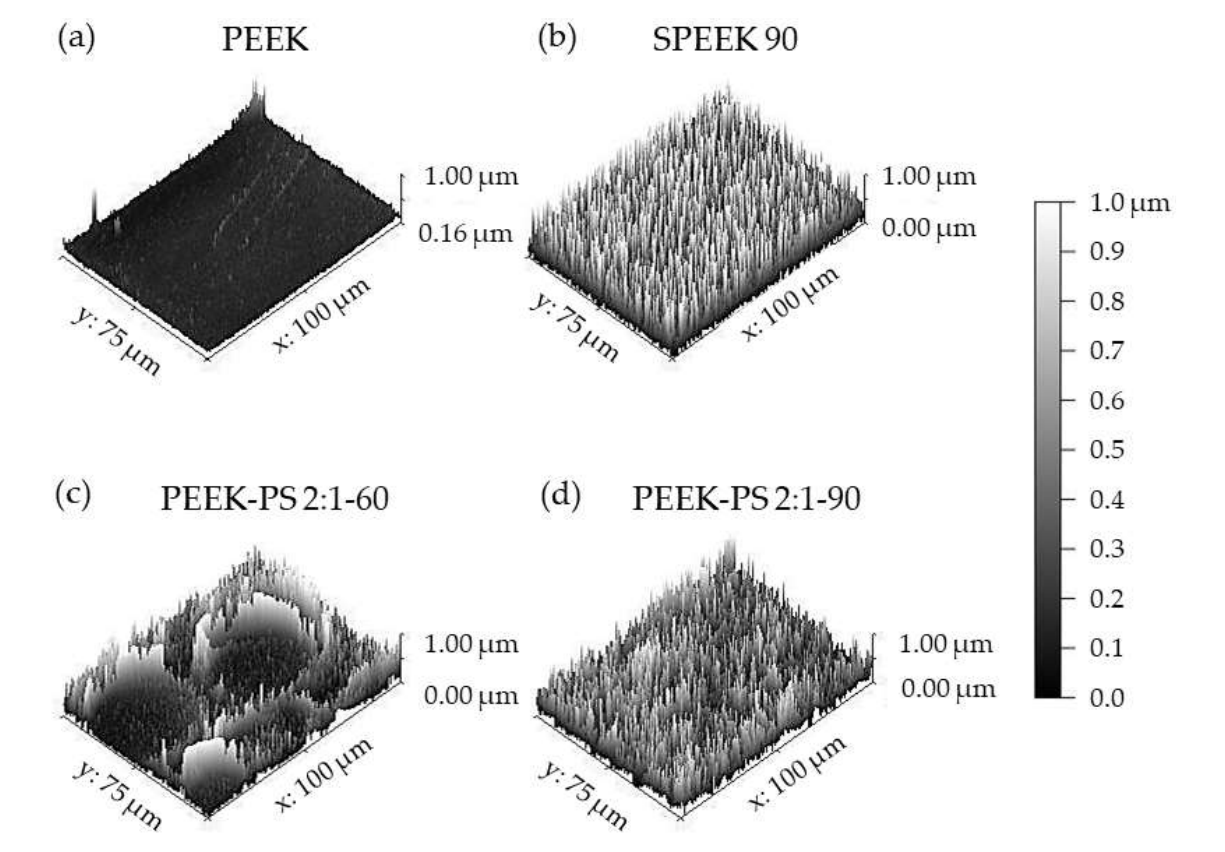
Figure 9. Comparison between topographic images of PEEK ( a ), SPEEK 90 ( b ), PEEK-PS 2:1-60 ( c ), and PEEK-PS 2:1-90 ( d ) obtained from SEM micrographs using Gwyddion software.